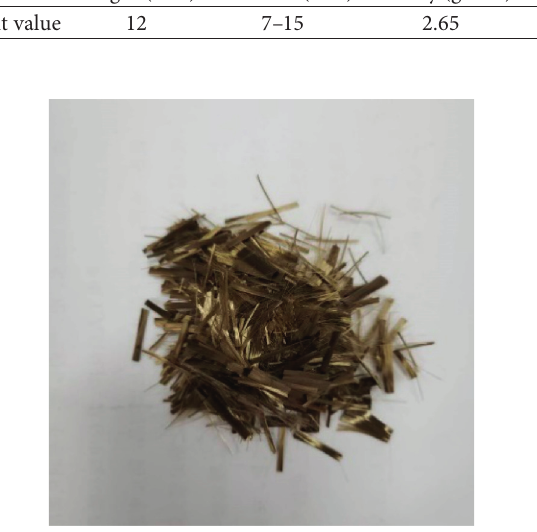
Figure 4: Basalt fibers.